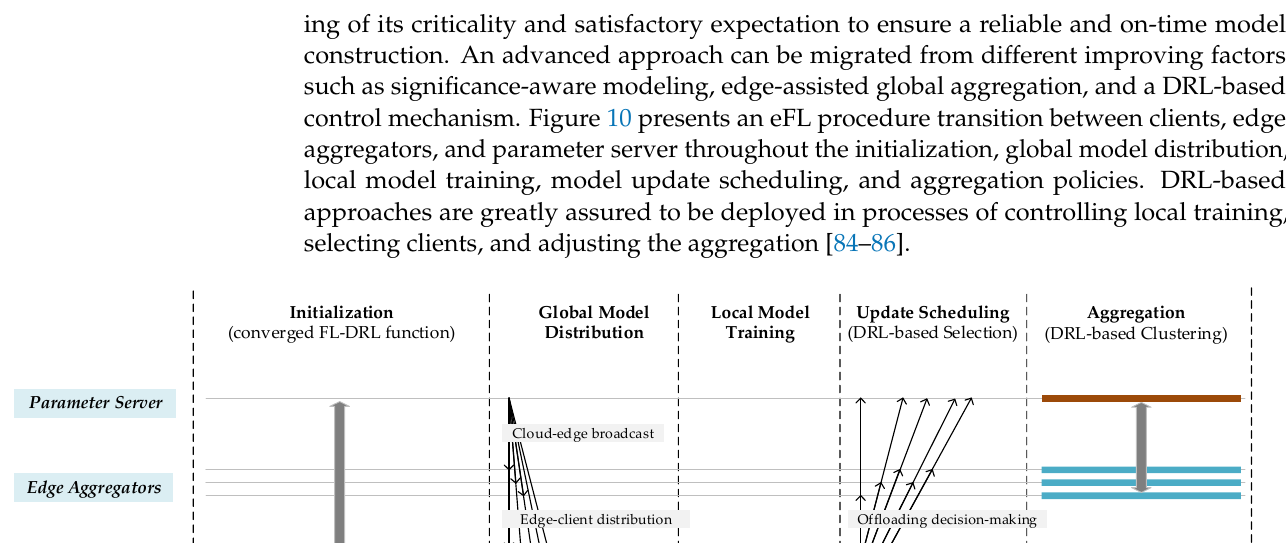
Table 5. Summary of Selected Works in Section 5, including DRL/FL-enabled Domains and Contri- butions.